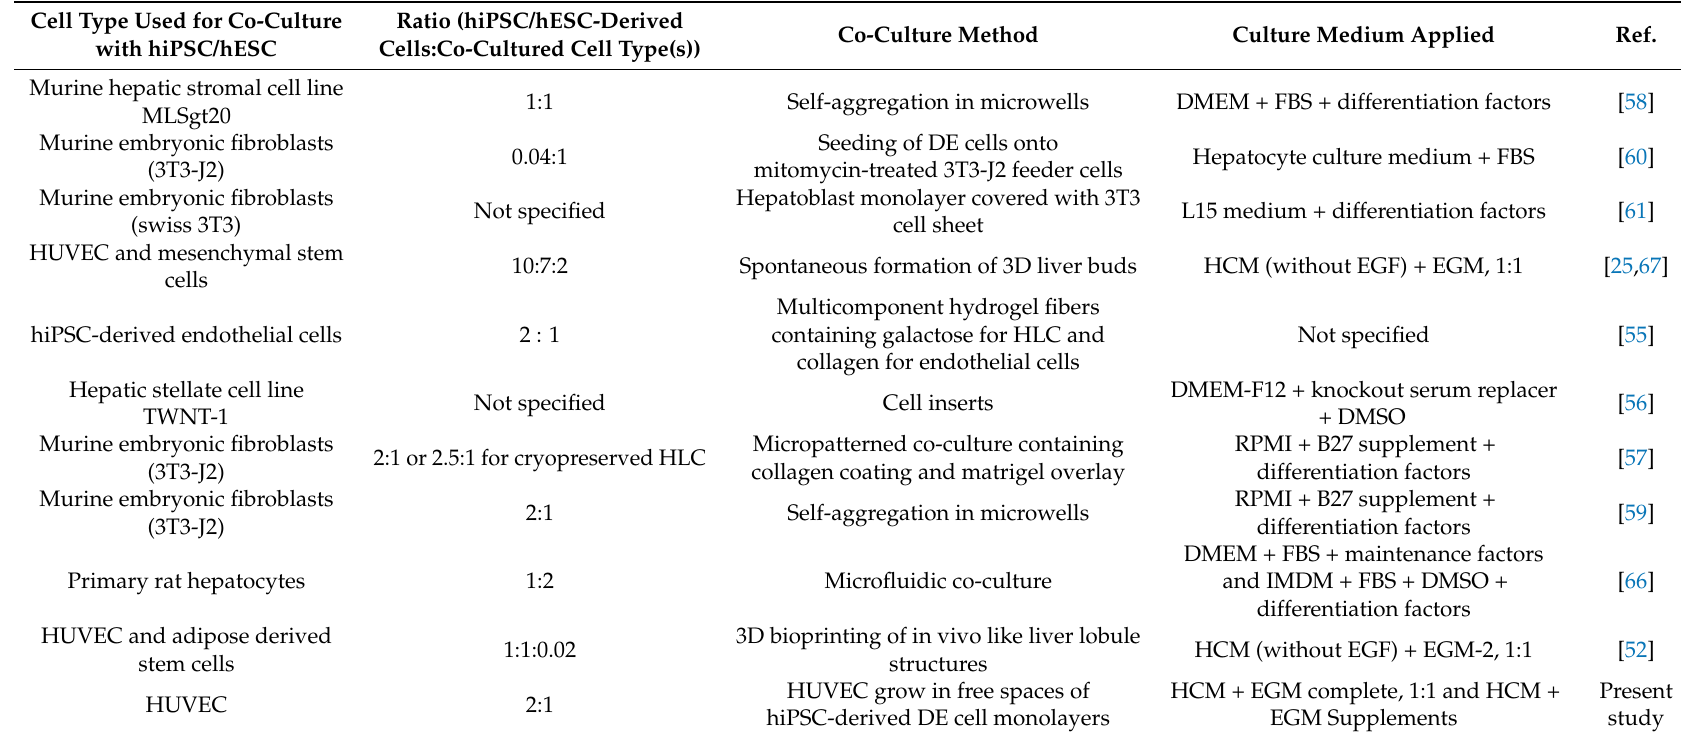
Table 1. Studies on hepatic differentiation of human induced pluripotent stem cells (hiPSC) or human embryonic stem cells (hESC) in co-culture with different cell